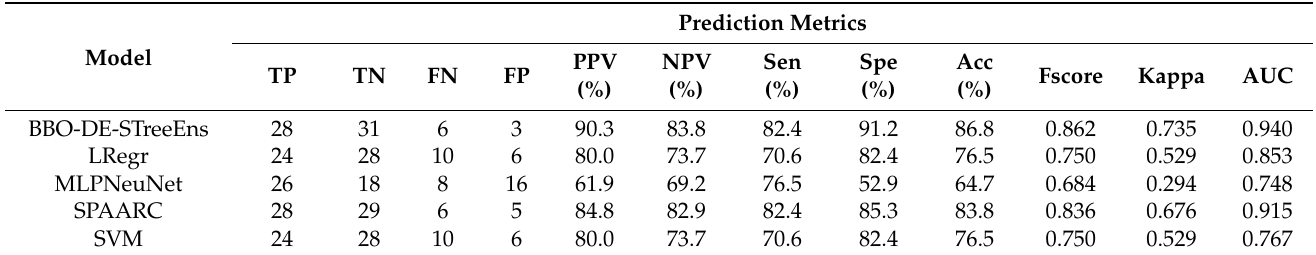
Table 2. Prediction performance of the proposed BBO-DE-StreeEns model and the benchmarks on the validation set.